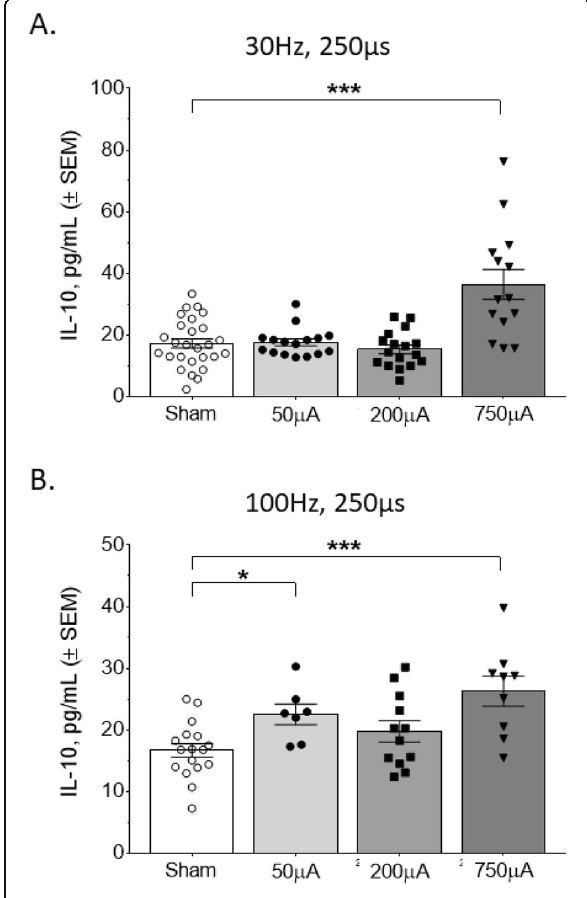
Fig. 5 Nerve stimulation with 250 μ s pulse width increased serum IL-10 at several different parameters. a Stimulation with 250 μ s pulses at 30 Hz produced a marked increase in IL-10 at the 750 μ A pulse amplitude. b Stimulation with 250 μ s pulses at 100 Hz produced significant increases at both 50 μ A and 750 μ A pulse amplitudes. Data is represented as individual mouse data points with mean ± SEM. n = 7 – 27 per group, *, P < 0.05; *** P <